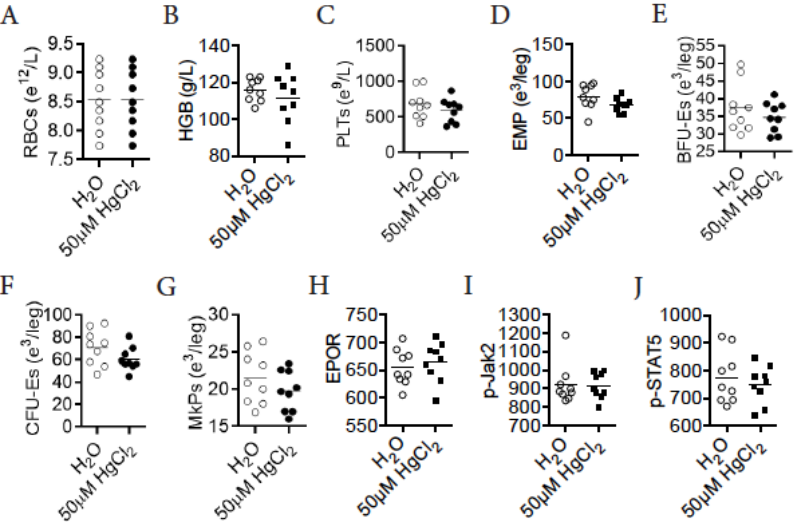
Figure 7. HgCl 2 does not impact erythro-megakaryopoiesis in DBA/2 mice. DBA/2 mice were treated with 50 µ M HgCl 2 or the control for 4 w, and RBT, erythropoiesis and the Jak2/STAT5 signaling pathway in EMPs were measured thereafter. ( A ) The concentration of RBCs in the blood. ( B ) The concentration of HGB in the blood. ( C ) The concentration of platelets in the blood. ( D ) The number of EMPs in the BM. ( E ) The number of BFU-Es in the BM. ( F ) The number of CFU-Es in the BM. ( G ) The number of MkPs in the BM. ( H ) The expression of EPOR (MFI) in EMPs in the BM. ( I ) The expression of p-Jak2 (MFI) in EMPs in the BM. ( J ) The expression of p-STAT5 (MFI) in EMPs in the BM. Each dot represents one mouse, and a total of nine mice were used for each group. p < 0.05 was considered as the level of significant